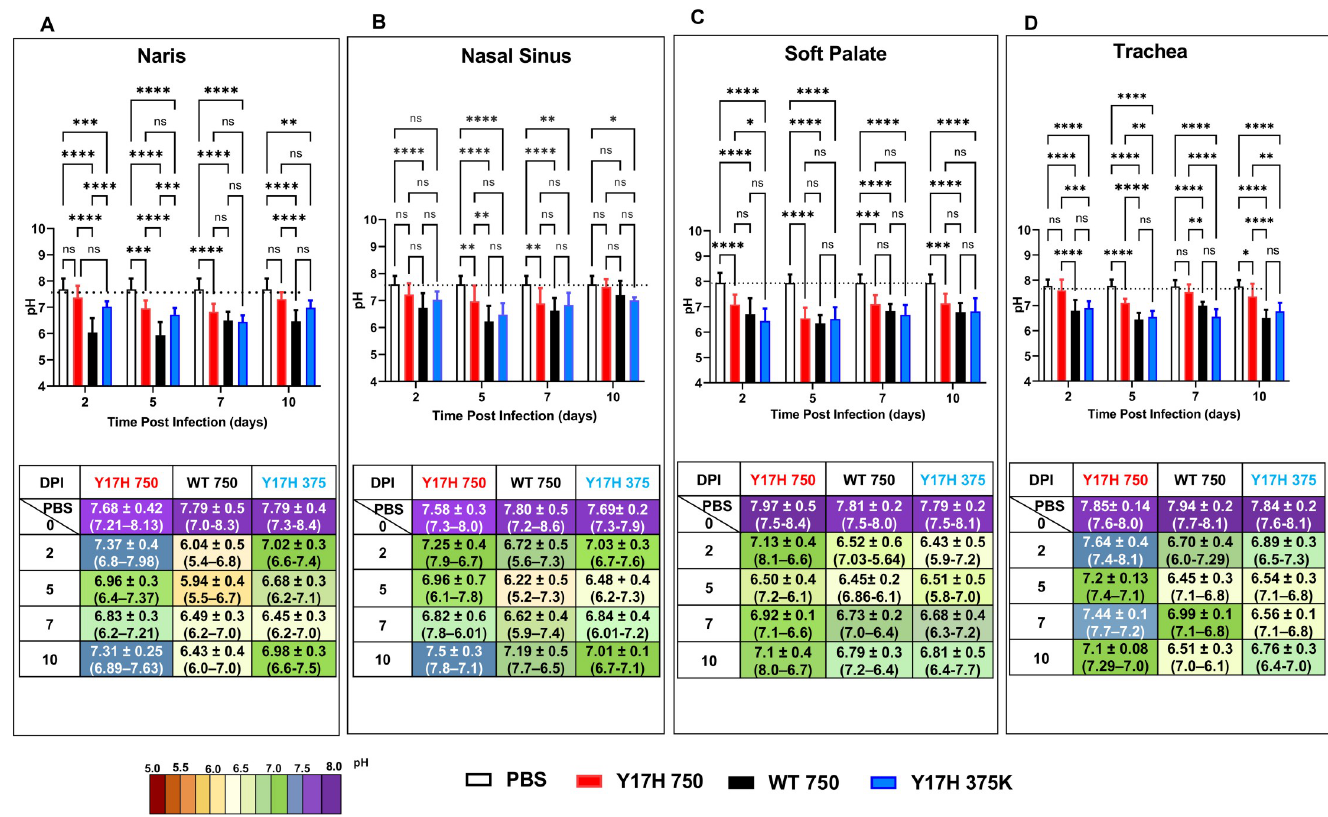
Fig 3. Extracellular respiratory tract pH in DBA/2 mice after infection. Mice were intranasally inoculated with PBS, WT virus (750 PFU), or Y17H virus (750 or 375,000 PFU). (A-D) Naris pH (A), nasal cavity pH (B), soft palate pH (C), and tracheal pH (D). Reported values are the means ± SD ( n = 10). The associated tables under the bar graphs contain the means ± SD ( n = 10), and the ranges are indicated in parentheses. Values are the combined mean ( ± SD) from two independent experiments with 40 mice total. Mice were intranasally inoculated with PBS, 750 PFU of WT virus, 750 PFU of Y17H virus, or 375,000 PFU of Y17H virus. After 2, 5, 7, or 10 days of infection, extracellular pH values were measured in the nares, nasal cavity, soft palate, and trachea with an optical pH microsensor. Measurements were taken under isoflurane-induced anesthesia. The mice were then euthanized, and tissues were collected and processed for further analysis. Two way-ANOVA and Tukey posthoc tests were performed on each day. Significant statistical differences are indicated as follows: � , P < 0.05; �� , P < 0.01; ��� , P < 0.001; ���� , P < 0.0001. Statistical significance tests compared the results to those for PBS-treated are shown in purple ( � ) or in connected lines and black ( � ) between groups. The bars for each group are colored as follows: PBS (white with black outline), WT (solid black), Y17H750-PFU (solid red), and Y17H 375-PFU (solid blue).